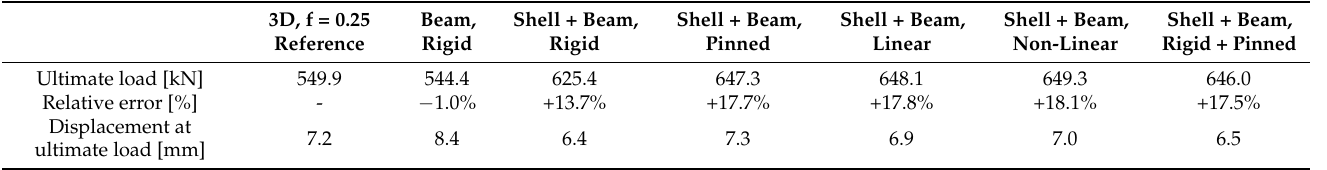
Table 5. Load capacity of the planar subassembly models compared.